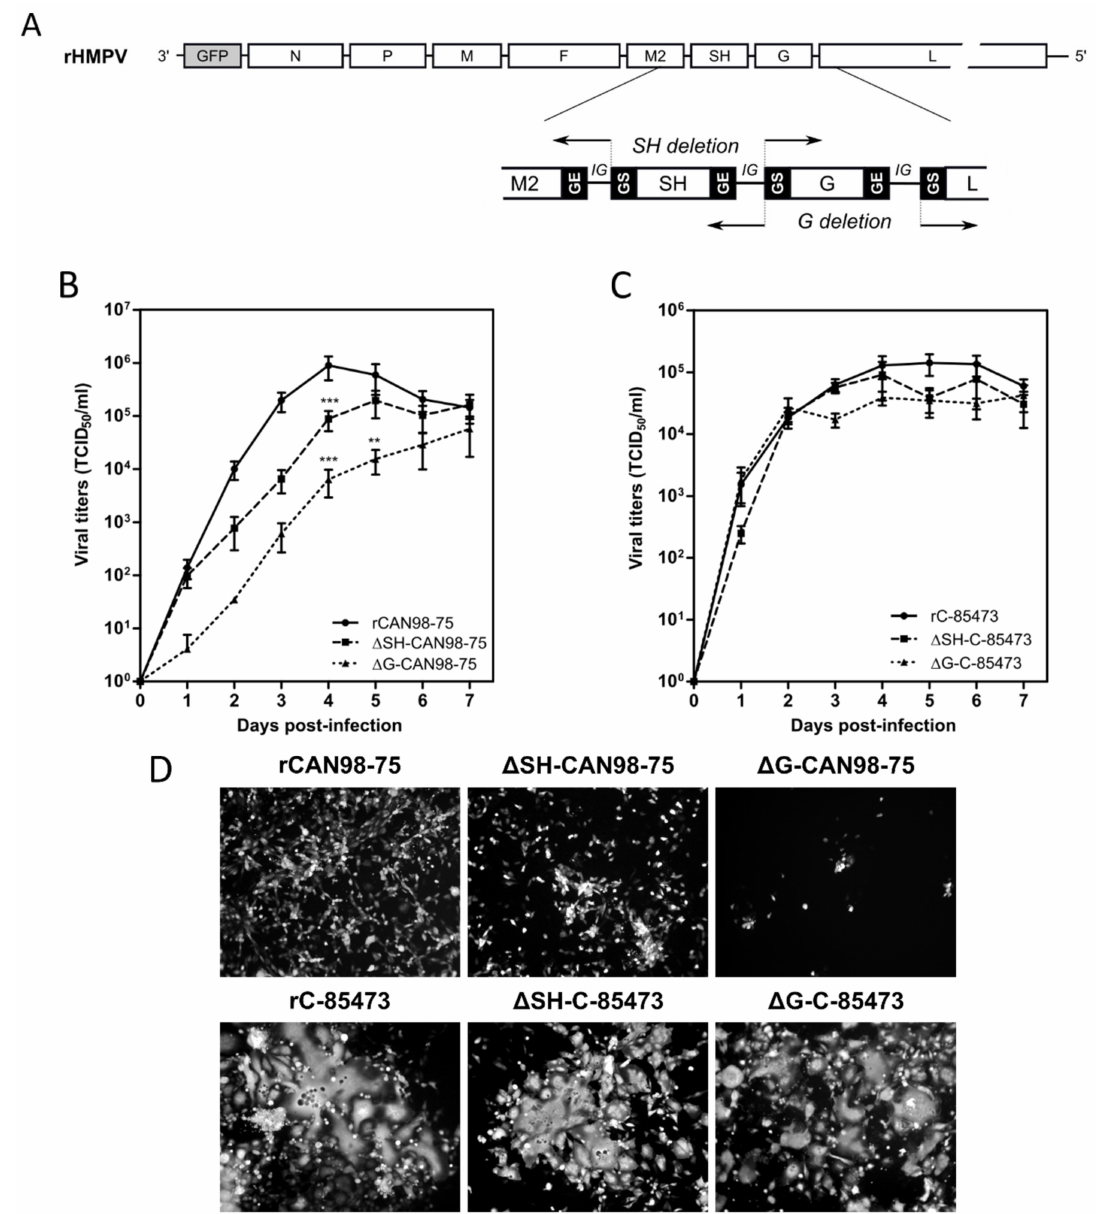
Figure 1. Construction of recombinant human metapneumovirus (HMPV) viruses and in vitro replicative capacity of SH and G-deleted rHMPV viruses. ( A ) Schematic representation of the genome of a recombinant GFP-expressing recombinant HMPV (rHMPV) viruses, with specific focus on the region of the genome describing the position of primers used for the deletion strategy (arrow, Table 1). GS: gene start. GE: gene end. IG: intergenic sequence. ( B , C ) LLC-MK2 monolayers in 24 wells-plates were infected with each of the six recovered rHMPV strains (rCAN98-75, ∆ SH-CAN98-75, ∆ G-CAN98-75; rC-85473, ∆ SH-C-85473, ∆ G-C-85473) at a MOI of 0.01. Supernatants were harvested every 24 h for seven days, frozen, sonicated and titrated as tissue culture infectious doses (TCID 50 ) / mL on LLC-MK2 cells. Growth curves represent mean titers of two independent experiments, with each time point titrated in triplicate. ** p < 0.01, *** p < 0.001 when comparing each ∆ SH / ∆ G virus to its wild type (WT) counterpart using repeated measures two-way ANOVA. ( D ) Images of representative cytopathic e ff ects and spread of each virus at three days post-infection were captured using fluorescent microscopy (10 ×